Question: In one sentence, what is this figure communicating?
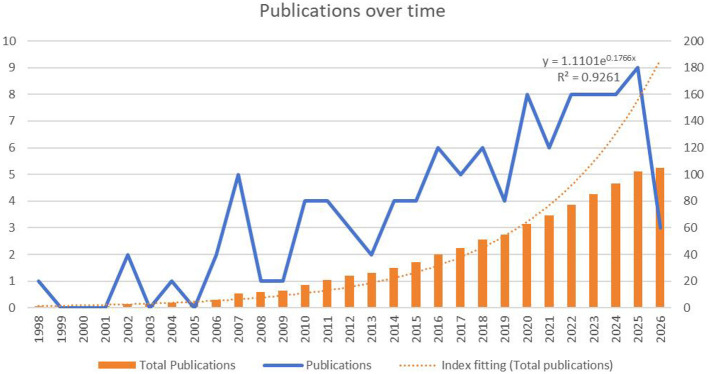
Answer: Annual publication trends in research on Chinese herbal medicine for cancer pain management. The blue line represents the annual number of publications, whereas the orange bars indicate the cumulative publication output. The dashed curve represents the exponential fitting of cumulative publications, illustrating the overall growth trend of research activity during the study period.